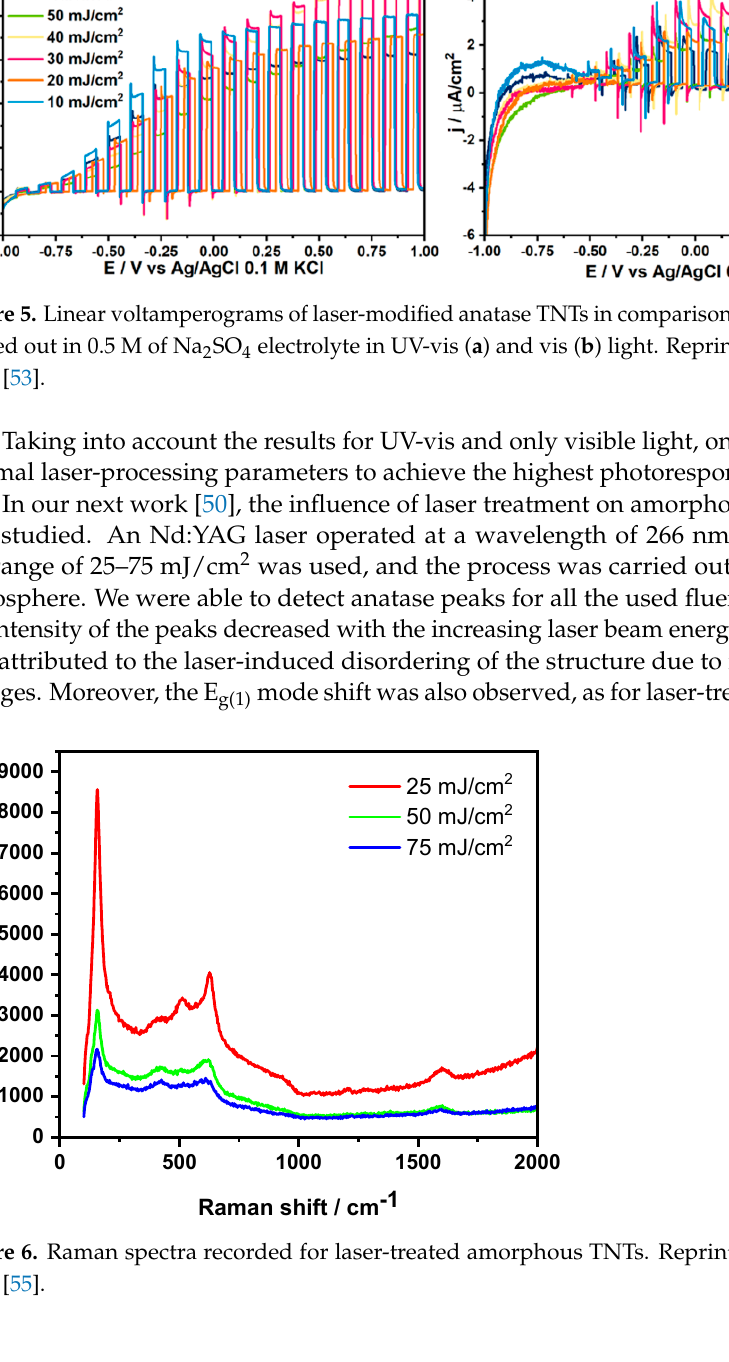
Figure 4. Raman spectra recorded for laser-treated TNTs in comparison to a calcined sample. Inset (a): dependence of the E g(1) position on the utilized laser energy fluences. Reprinted with permission from [53].